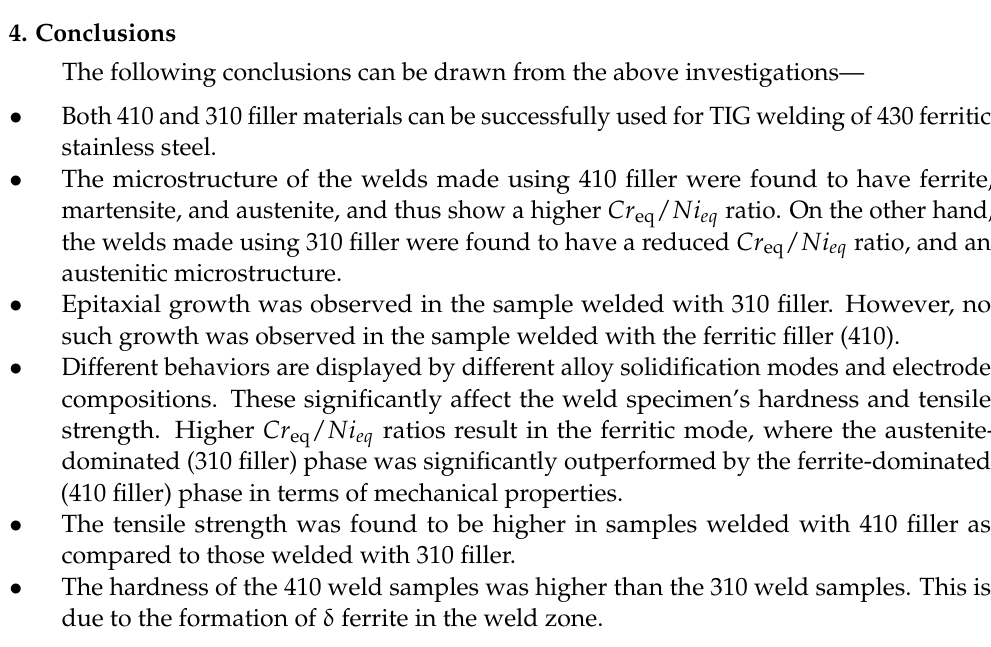
Figure 9. Microhardness profiles of ( a ) 310 SS filler and ( b ) 410 SS filler.